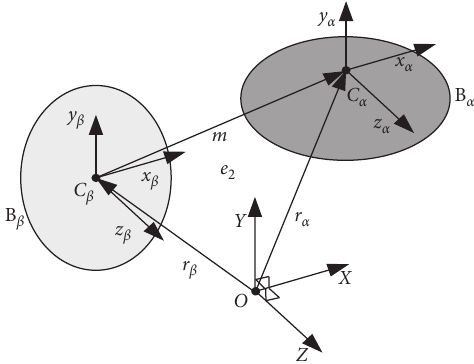
Figure 2: Kinematic relationship between rigid bodies in the generalized coordinate